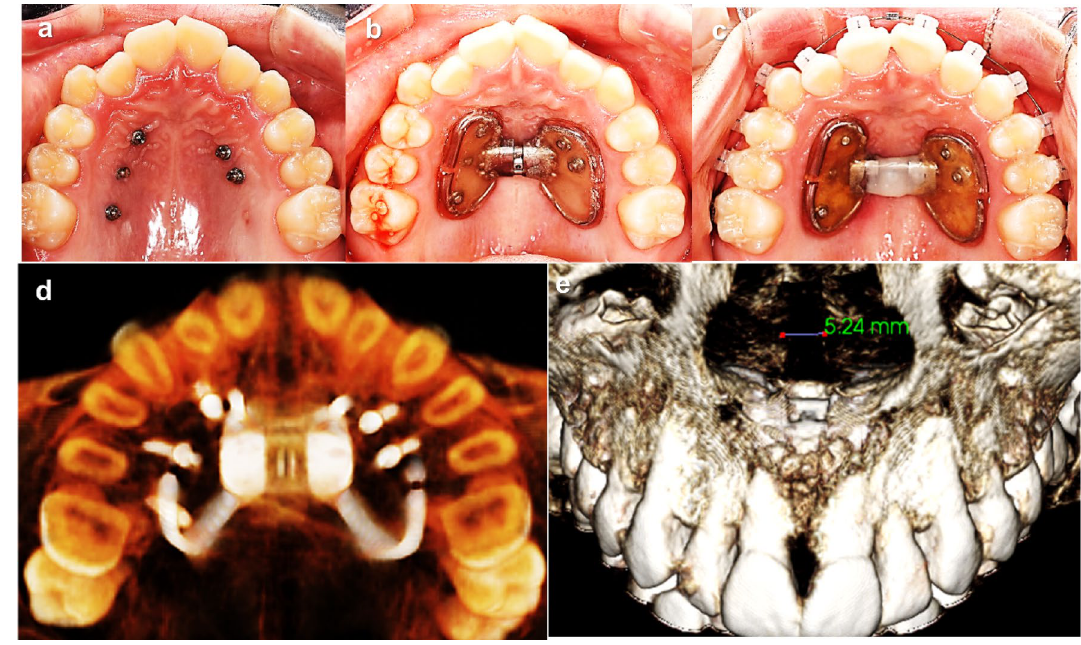
Figure 2. Clinical application of C-expander using self-drilling miniscrews. ( a – c ) Occlusal photographs of 13 years female patient. After placement of miniscrews (One miniscrew was loosened during healing period) ( b ), after C-expander application ( c ), after 7 mm of C-expander activation. ( d , e ) Cone beam computed tomography (CBCT) images of 17 years old female patient treated by six miniscrews assisted C-expander. 5.24 mm of suture separation was achieved after C-expander activation.